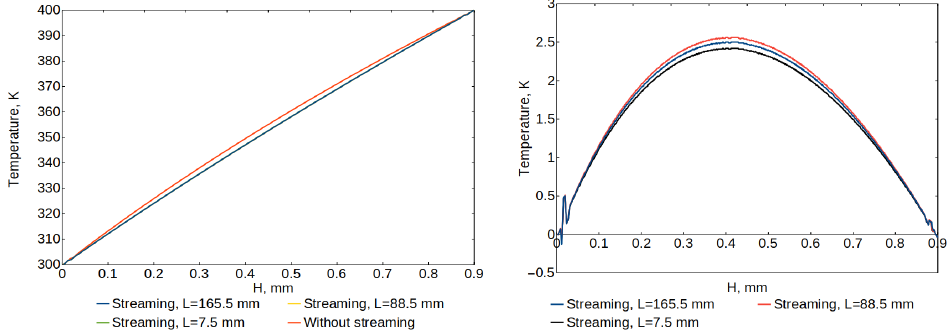
Figure 16. Comparison of the vertical temperature profiles of the flow with and without streaming for 3 locations L = ( 7.5,88.5,165.5 ) mm. ( Left ): temperature profiles; ( Right ): temperature difference between flow with and without